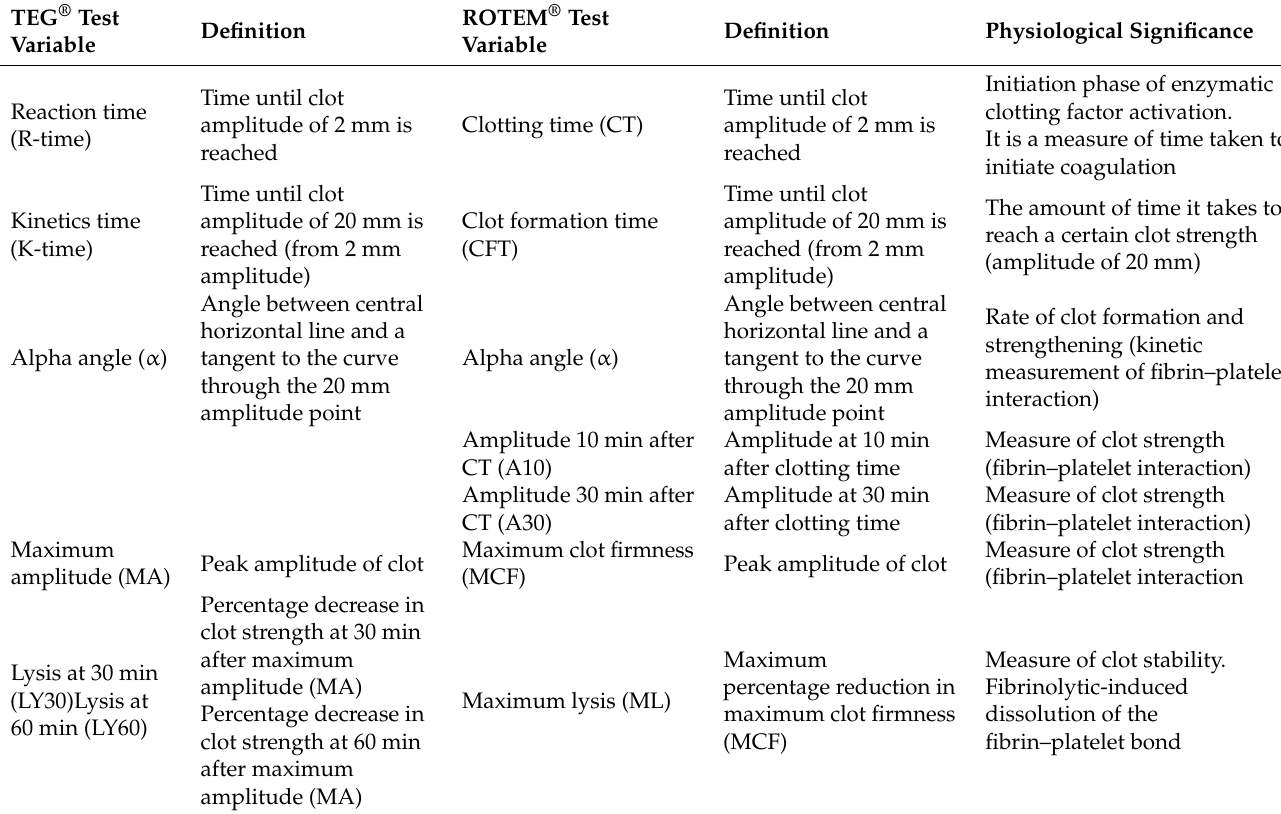
Table 1. Comparison of TEG ® and ROTEM ® parameters and relative physiological significance.